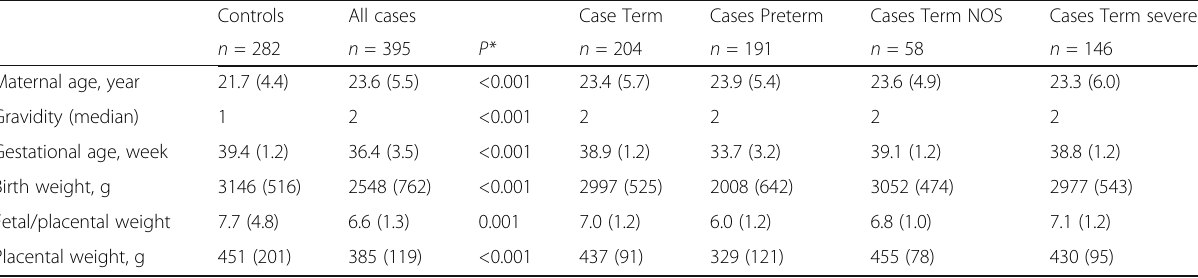
Table 1 Demographics of study population and case subgroups, mean